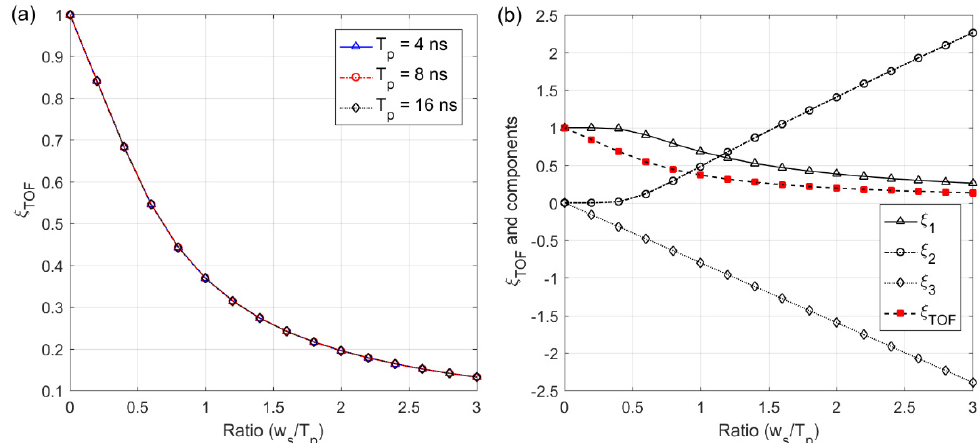
Figure 8. Pulse broadening effect factor at the maximum cross-correlation ( a ) and its individual component values ( b ) at T p = 8 ns. The components of ξ 1 , ξ 2 , and ξ 3 correspond to the first, second and third terms in the definition of the pulse broadening effect factor given in Equation (19).